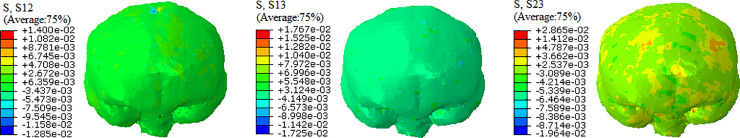
Shear stress of frontal brain tissue.(A) XY plane. (B) XZ plane. (C) YZ plane.